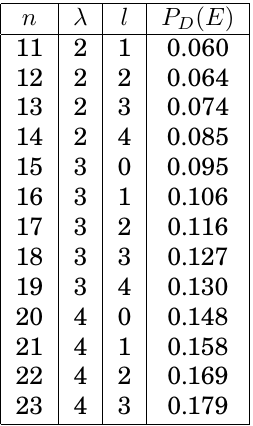
Table 2: Table of P D ( E )